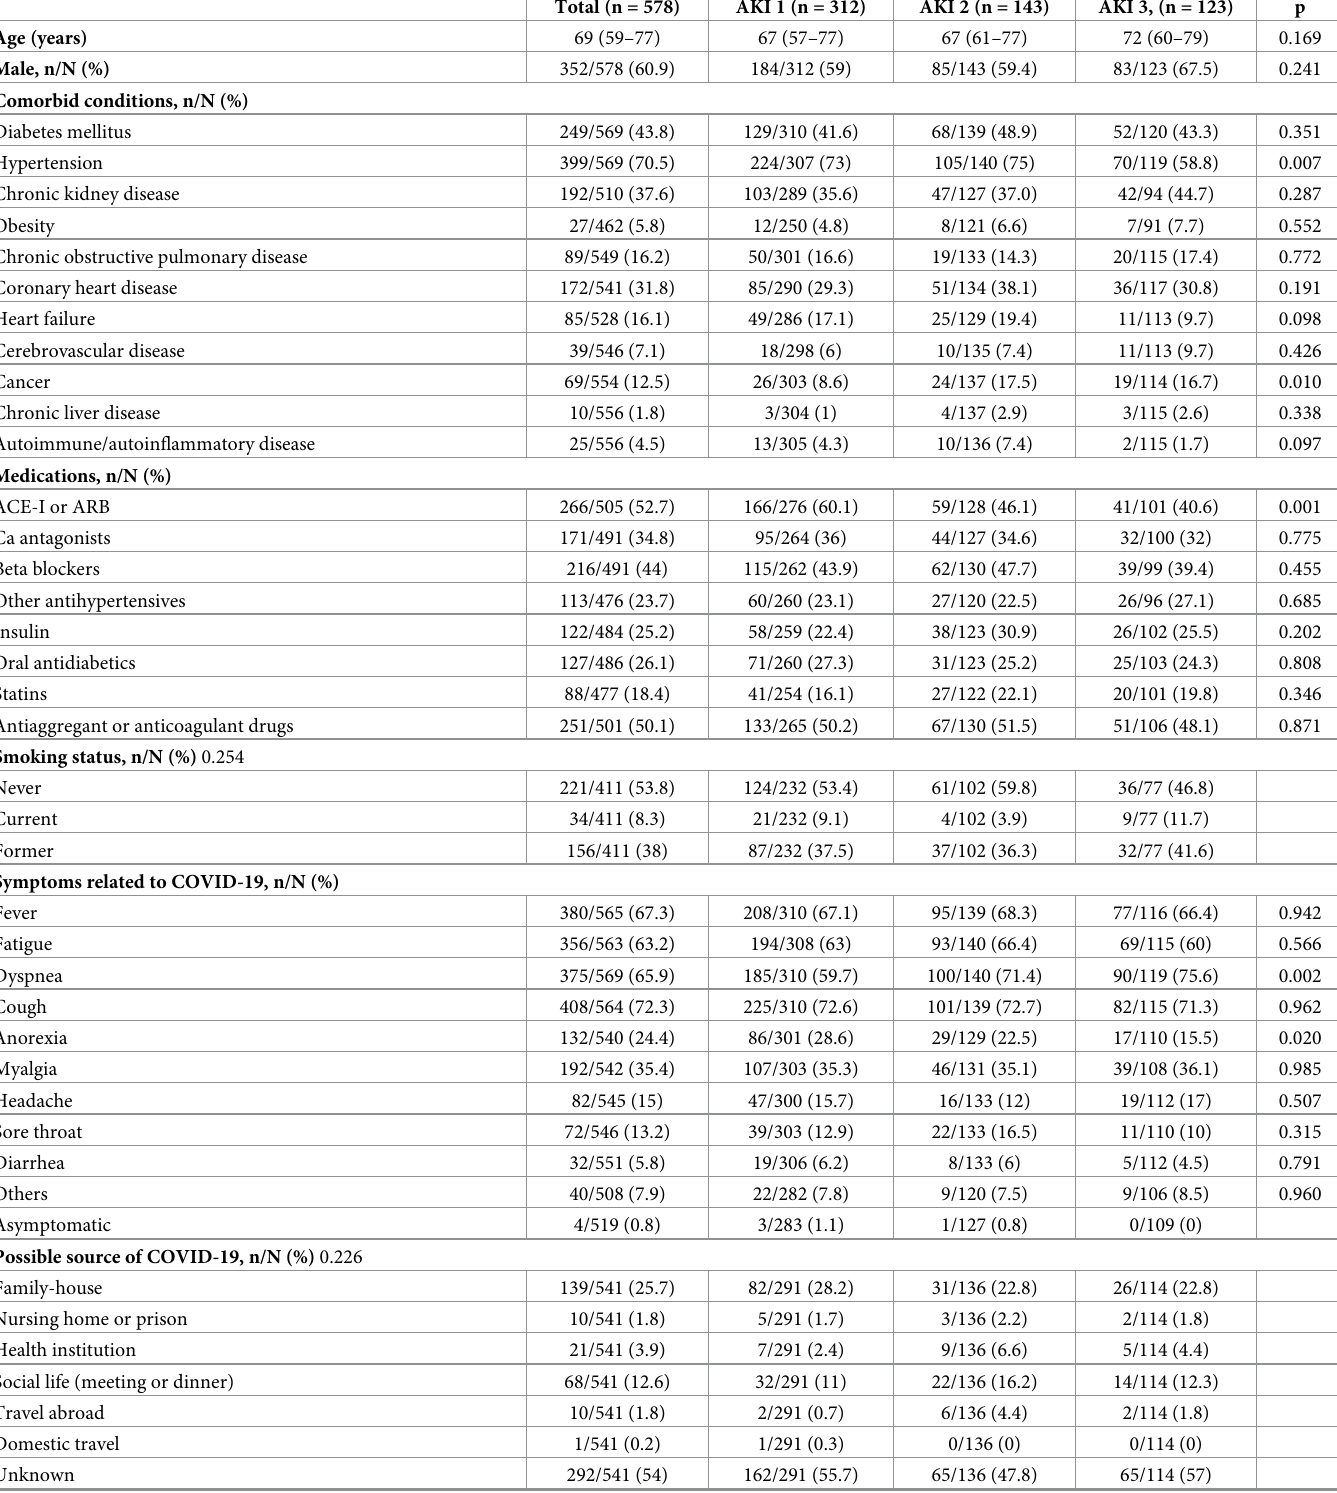
Table 1. Characteristics of COVID-19 RT-PCR positive patients during hospital admission and hospital stay, by AKI